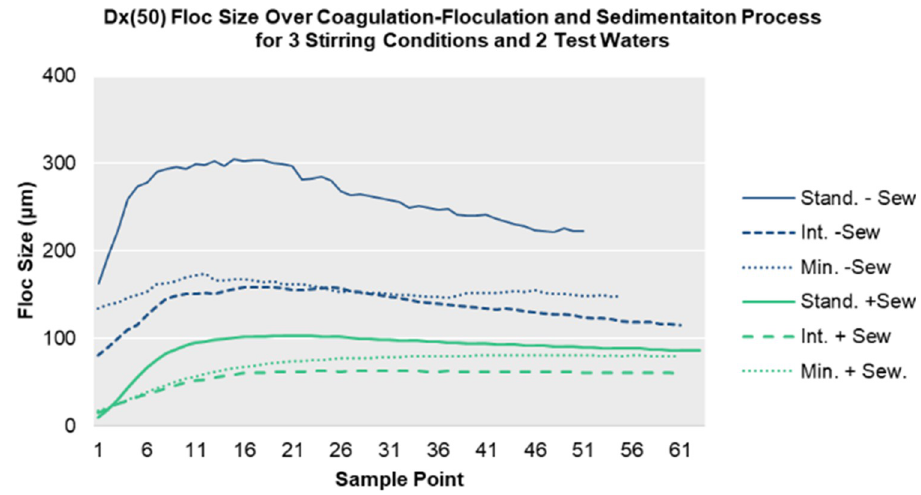
Fig 2. Average median floc size measurements for three stirring conditions and two challenge water types over the coagulation-flocculation sedimentation process. (p < 0.000010) (S10 Table in S1 File). Standard stirring procedures were found to produce